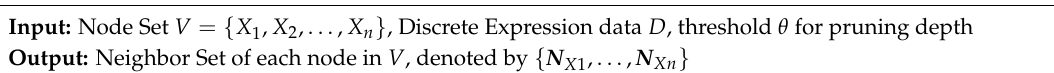
Algorithm 1. The Flooding-Pruning Neighbor Selection algorithm